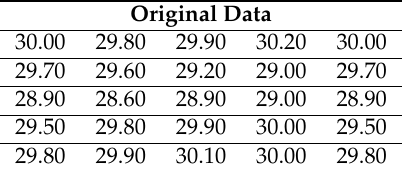
Table 8. Table representing a RoI of the scenario which is divided into 5 rows and 5 columns. Each of the cell corresponds to a specific area of the scenario whose real values is represented in ◦